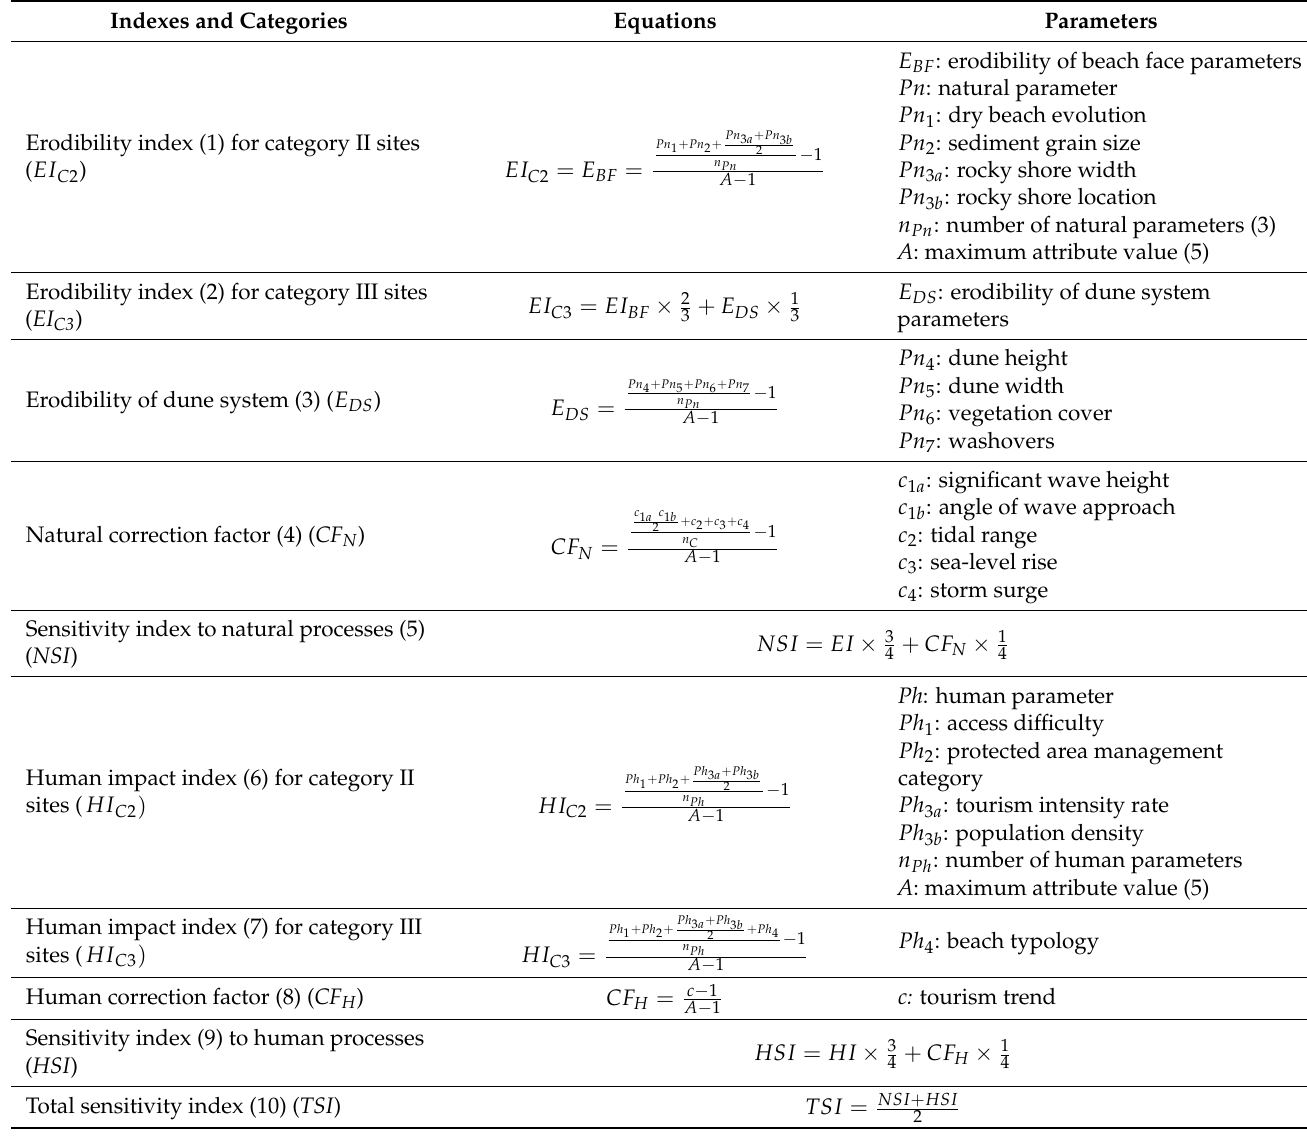
Table A1. Equations used for the assessment of EI, NSI, HI, HSI, TSI and correction factors (natural and human) (CSSI